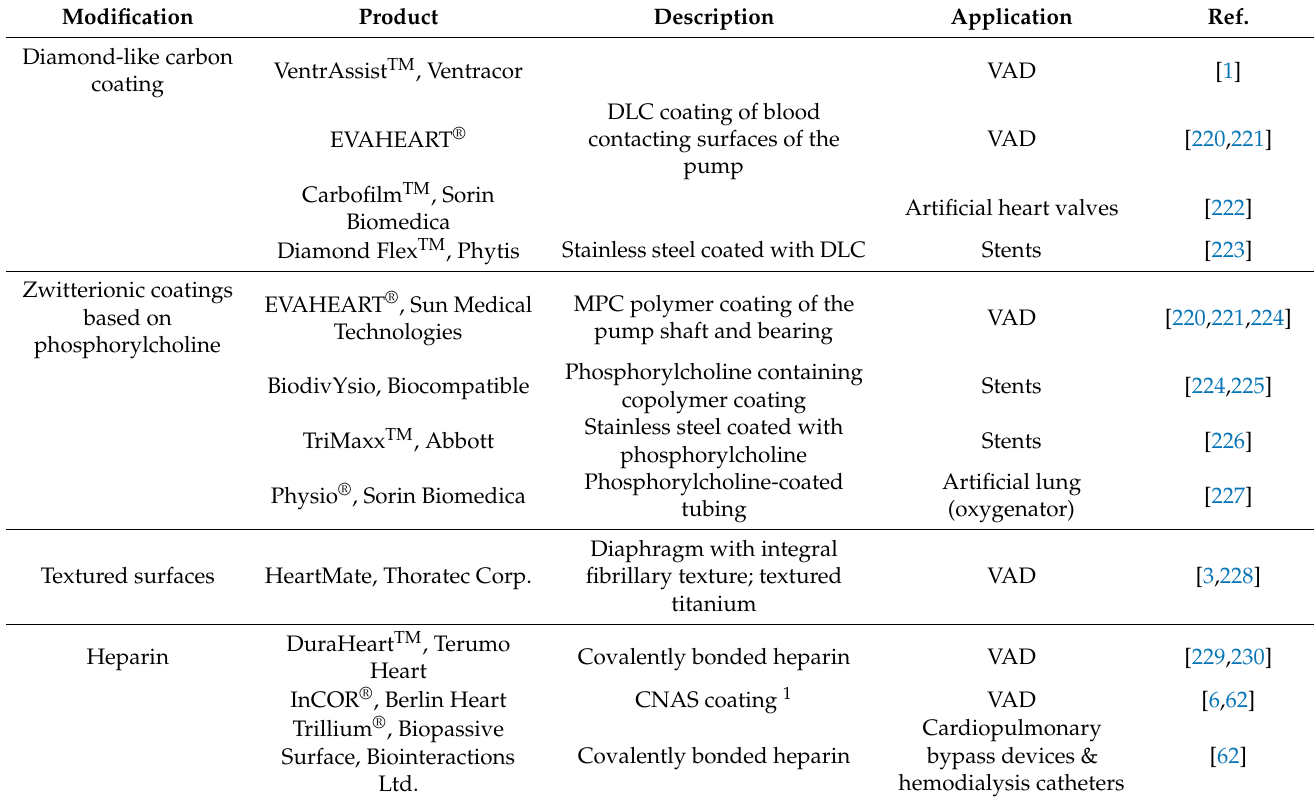
Table 1. Examples of commercially applied surface modifications for medical